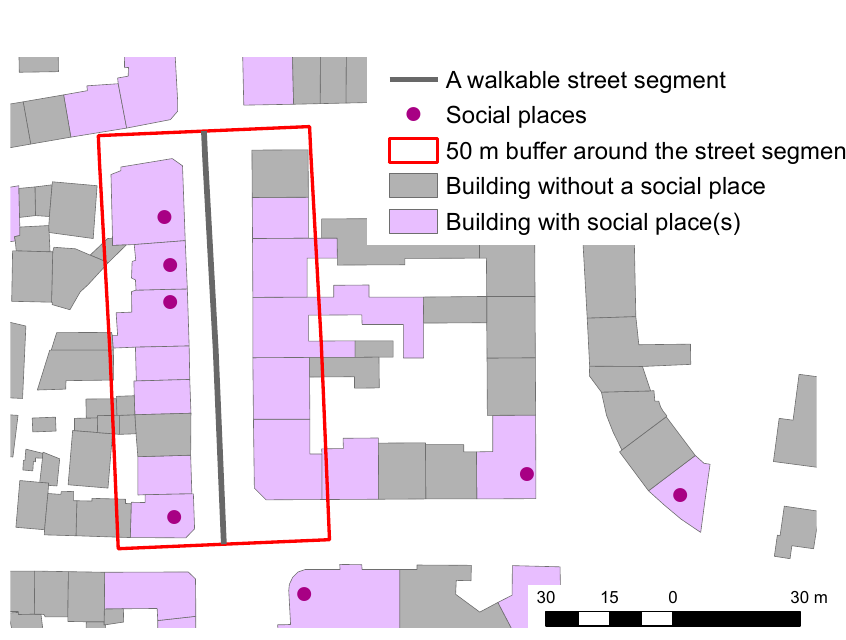
Figure 2. Example of a street segment and a 50 meter buffer zone around it. OpenStreetMap features intersecting the buffer and containing at least one of the tags indicate third places (Table 1) and were considered for the measurement of the street segment’s